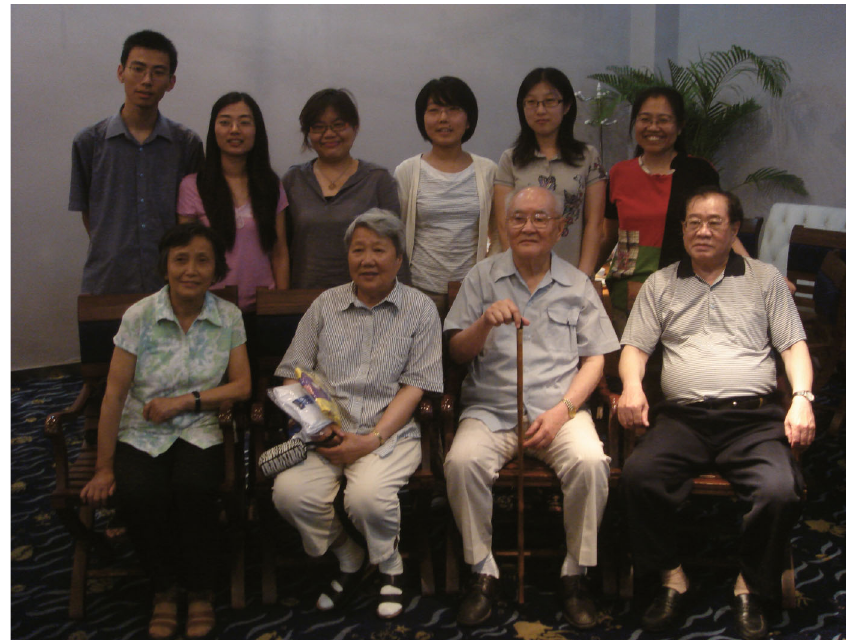
Figure 4. Jiao Shao and his young